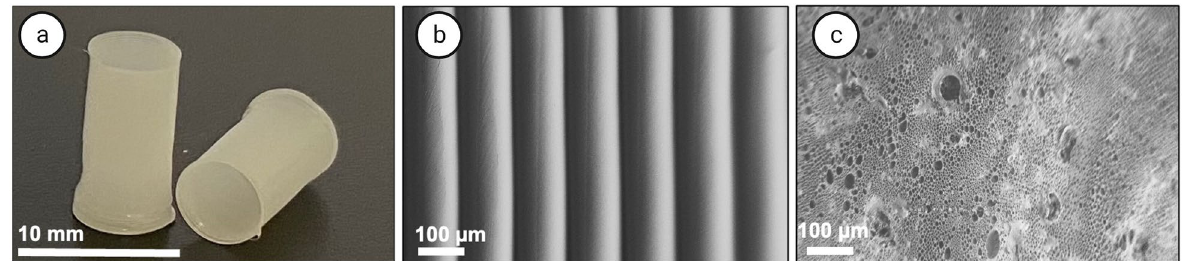
Figure 2. Morphology visualization of SDVGs with and without the coating. Macroscopic image of 3D printed tubes ( a ) and SEM images of 3D printed tube ( b ) and the coated tube with 10% (w/w) SNAP-matrix—10% (w/w) SNAP-MWCNTs-OH ( c